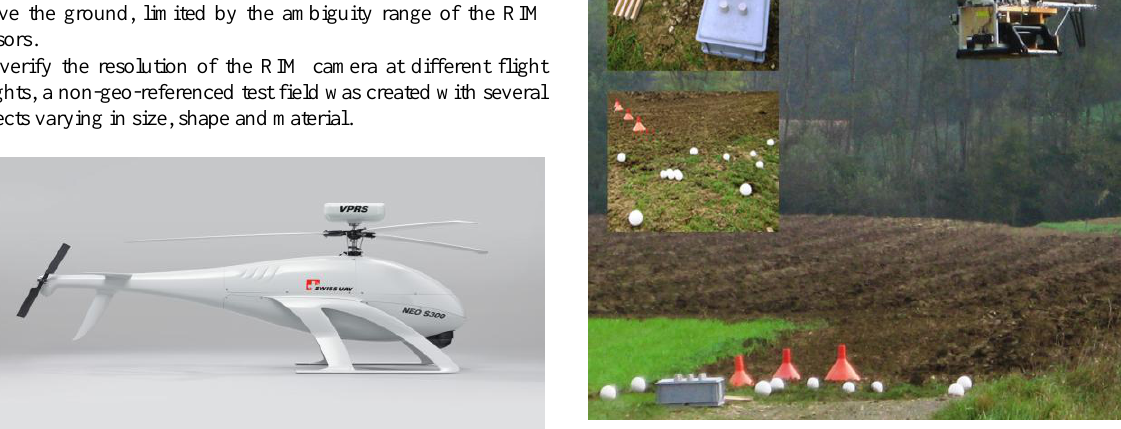
Figure 4 Unmanned helicopter NEO S-300 series.